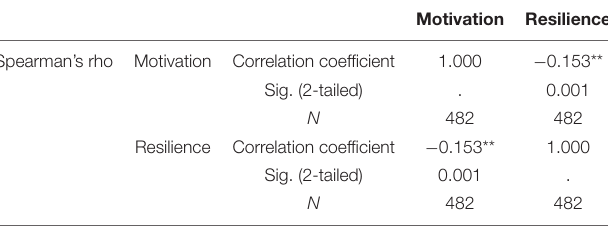
TABLE 3 | Correlations for learners’ motivation and their resilience.